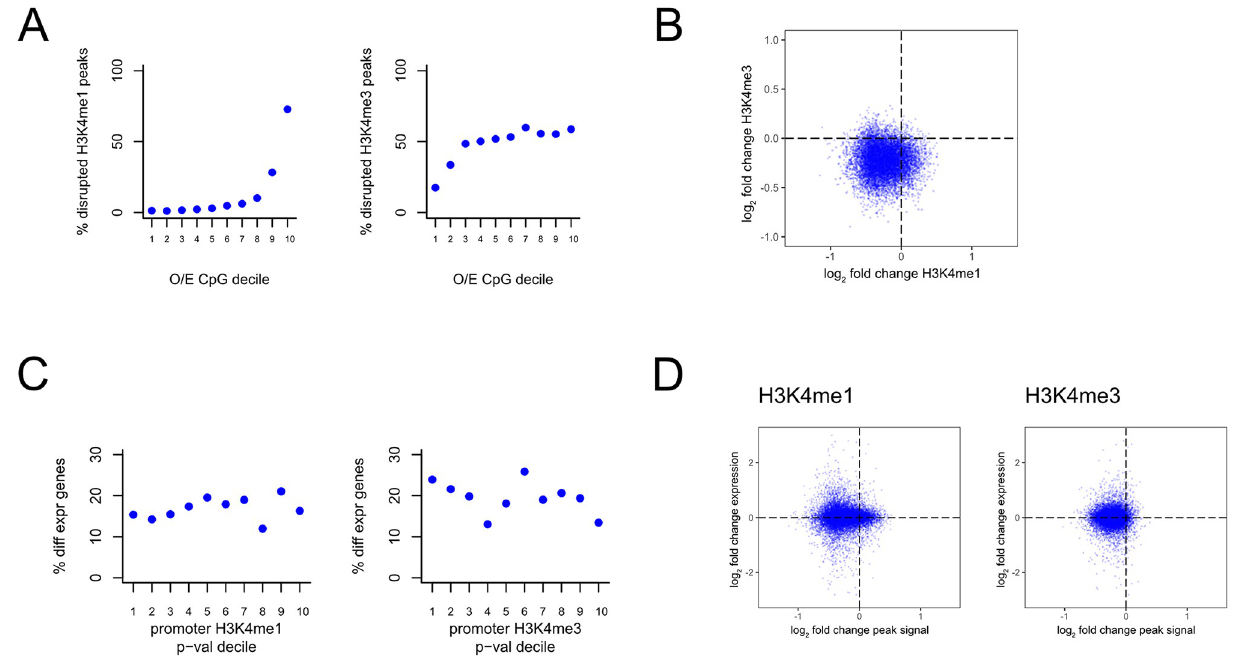
Fig 2. The relationship between disrupted H3K4me1/3, regional observed-to-expected CpG ratio, and gene expression in Kmt2a -deficient mice. (A) The percentage of disrupted H3K4me1 peaks (left) and H3K4me3 peaks (right), stratified based on the observed-to-expected CpG ratio of the underlying peak sequence. (B) Scatterplot of the log 2 fold change of H3K4me1 peaks against the log 2 fold change of H3K4me3 peaks at promoters (+/-1kb from the TSS) that harbor peaks for both marks. (C) The percentage of differentially expressed genes, stratified based on the p-value of associated promoter peaks (+/- 1kb from the TSS) from the differential H3K4me1 analysis (left) and H3K4me3 (right) analysis. (D) Scatterplot of the log 2 fold change of H3K4me1 peaks (left) and H3K4me3 (right) against the log 2 fold change of gene expression of the downstream gene. Each point corresponds to a gene-promoter pair. In cases where multiple peaks were present at the same promoter, the average log 2 fold change was computed.